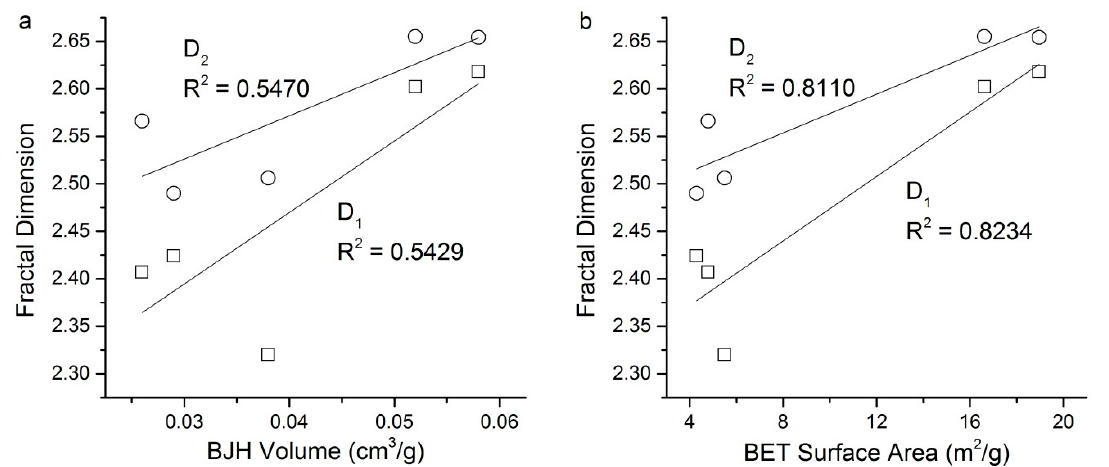
Figure 12. Relationships between pore structure parameters and fractal dimension (mass fraction). ( a ) BJH volume; ( b ) BET surface area. The hollow rectangles denote the fractal dimension D 1 , and the hollow circles indicate the fractal dimension D 2 . R 2 is the correlation coefficient.